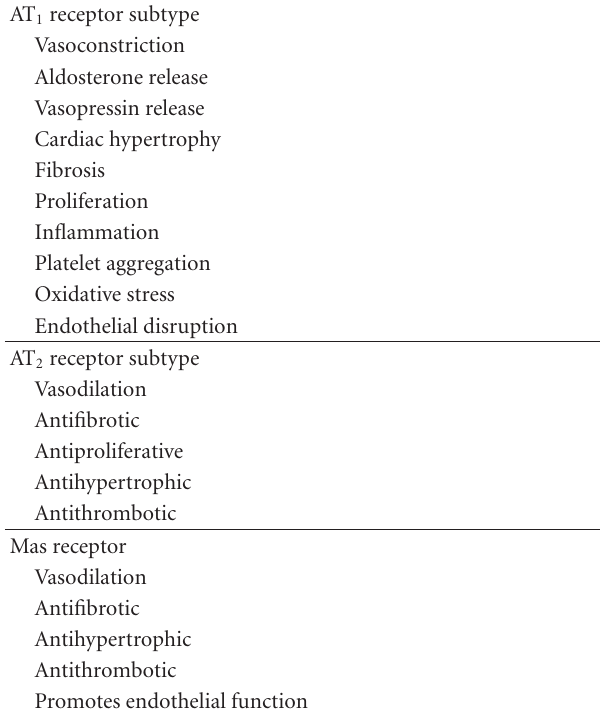
Table 1: Functions associated with ligand activation of the AT 1 , AT 2 , and Mas